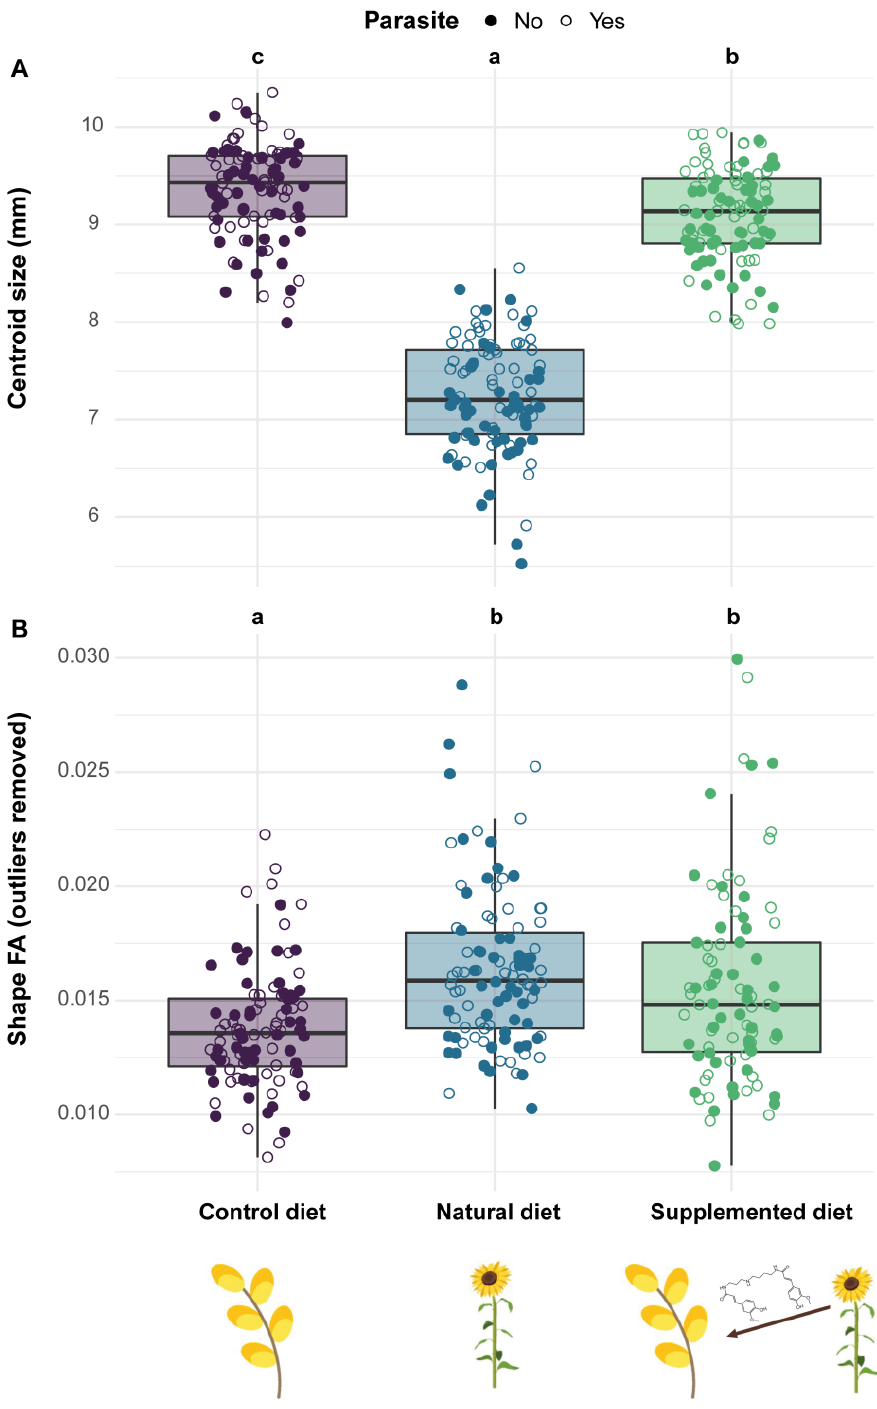
Figure 7. Phenotypic variation in emerged males among treatments. ( A ) The right forewing centroid size — a proxy for body size — is defined as the square root of the sum of squared distances between all landmarks and their centroid. ( B ) The shape fluctuating asymmetry (FA) is defined as the square root of the sum of each squared value of each landmark (x and y; no unit). Two treatments sharing a letter are not significantly different (GLMMs).